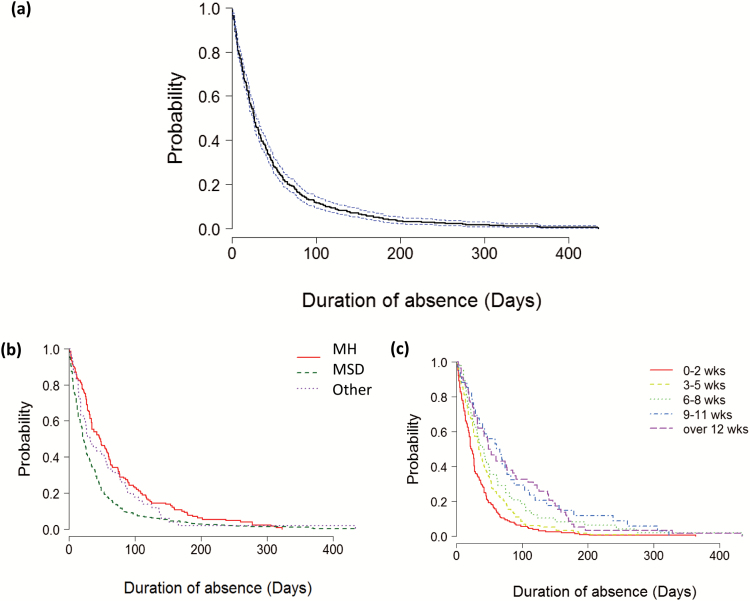
Survival analysis; (a) Kaplan–Meier RTW curve for all: number of days lost due to SA (solid line) with 95% CI (dotted line; N = 649); (b) Kaplan–Meier RTW curve by primary condition (MH = mental health cases; MSD = musculoskeletal cases); and (c) median length of time (days) being absent since entry assessment by the number of weeks absent before entry assessment.